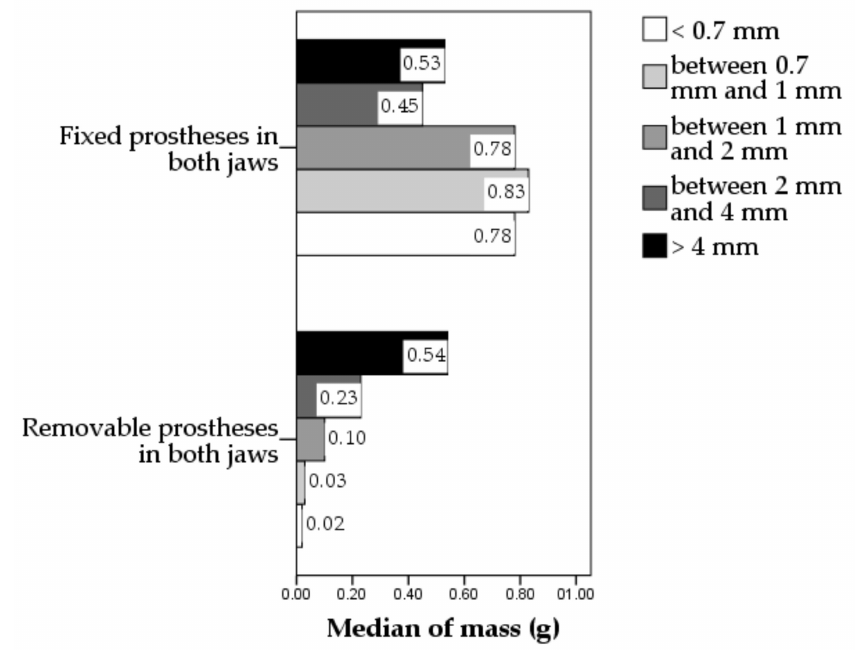
Figure 2. Particle size distribution in patients wearing fixed or removable prostheses.